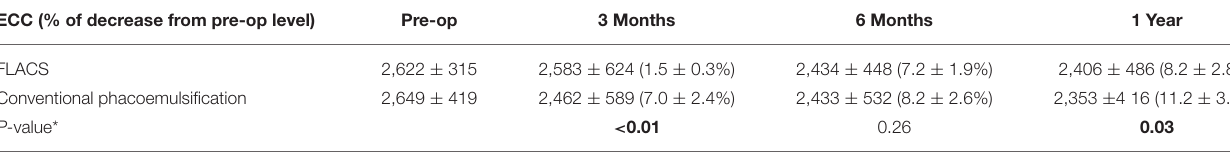
TABLE 1 | Post-operative ECC changes in 2 groups over 1-year period. ECC (% of decrease from pre-op level)